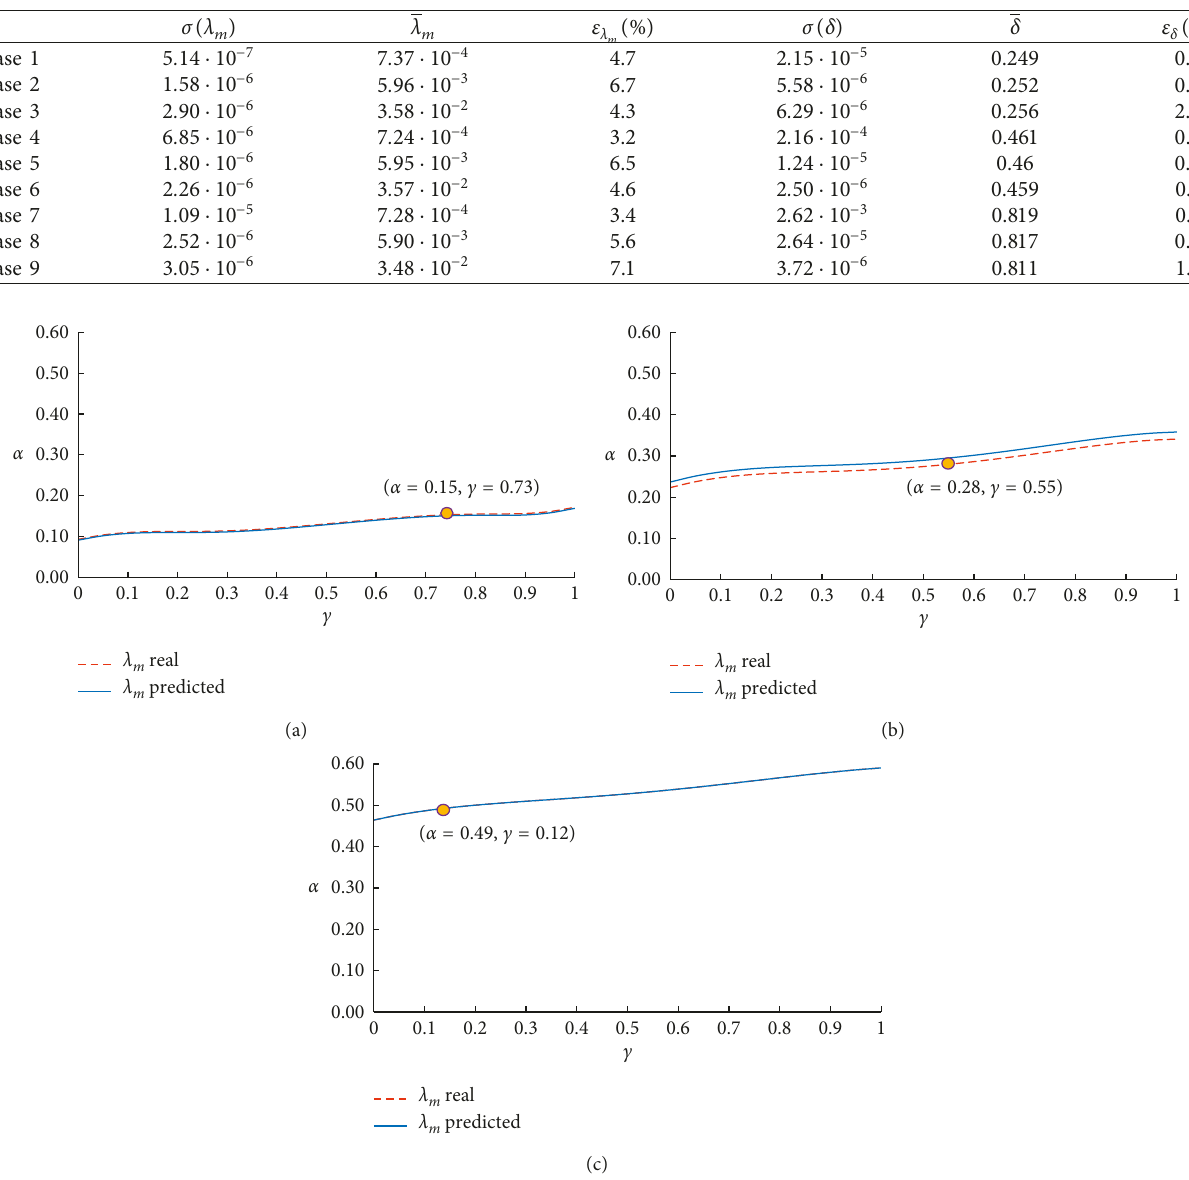
Figure 8: λ m values in function of α and Table 4: Location and flexibility errors.